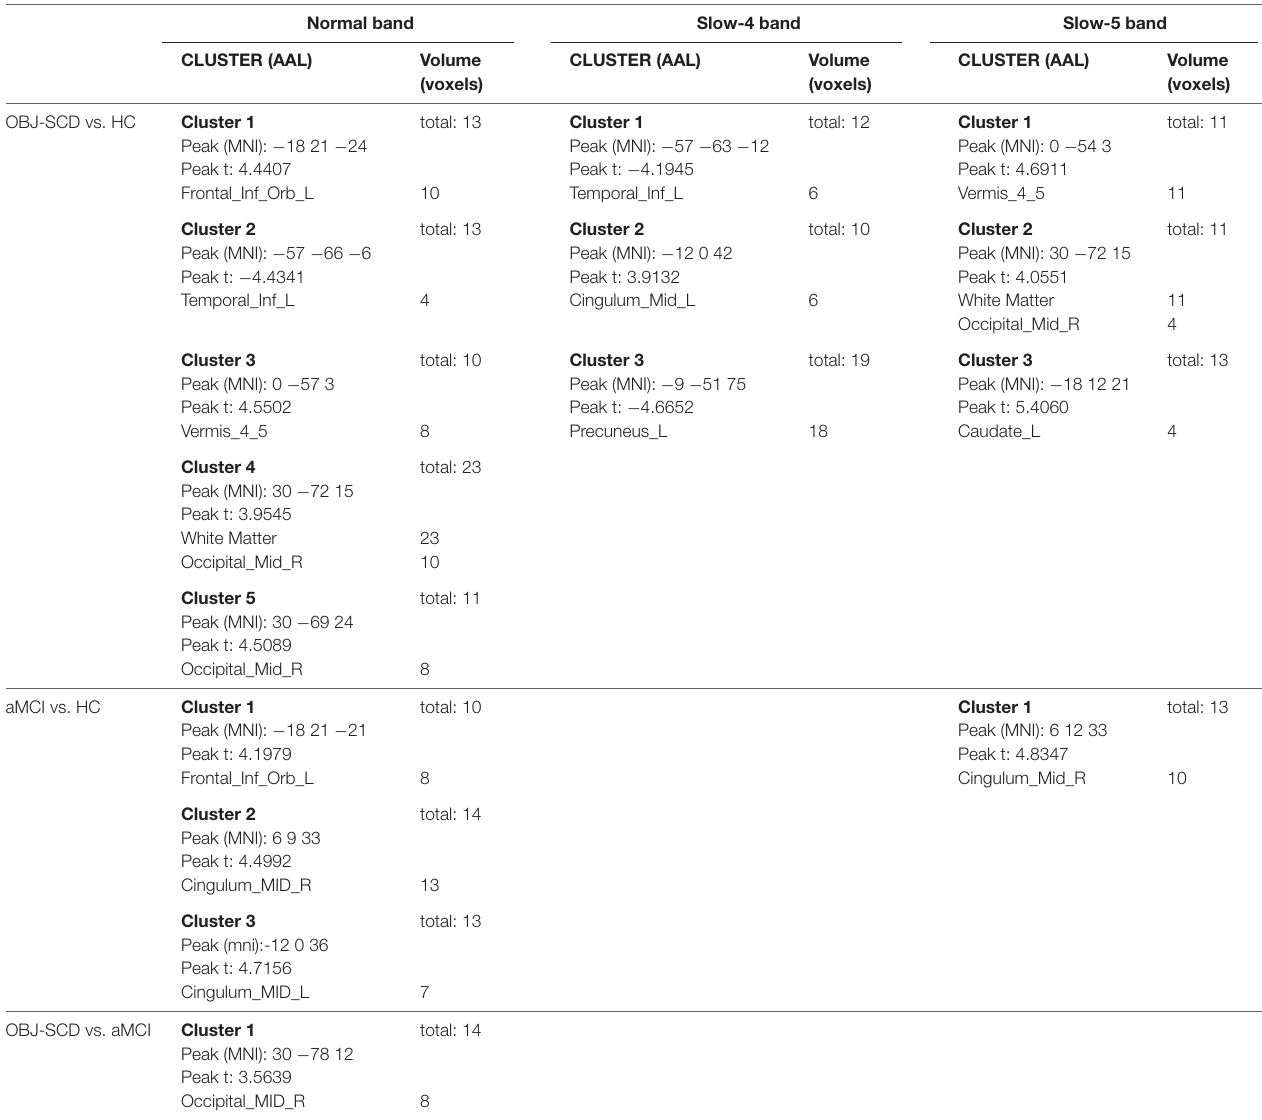
TABLE 2 | Regions with changed functional activity (fALLF) between groups. Normal band Slow-4 band Slow-5 band CLUSTER (AAL) Volume (voxels) OBJ-SCD vs.